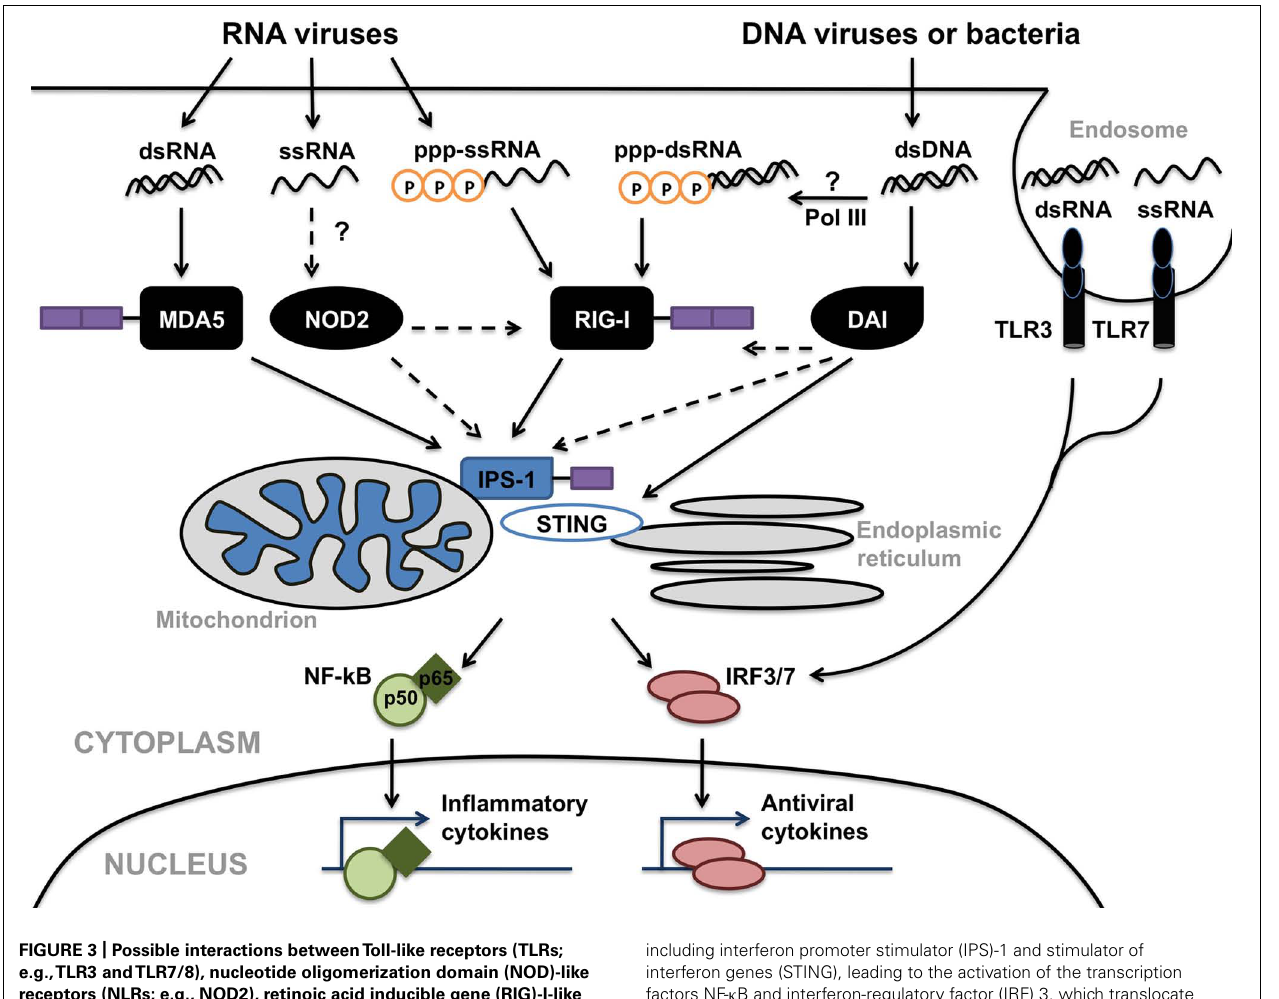
FIGURE 3 | Possible interactions betweenToll-like receptors (TLRs; e.g.,TLR3 andTLR7/8), nucleotide oligomerization domain (NOD)-like receptors (NLRs; e.g., NOD2), retinoic acid inducible gene (RIG)-I-like receptors (RLRs; e.g., RIG-I and MDA5) and DNA-dependent activator of IFN regulatory factors (DAI) in the detection of viruses and the initiation of glial immune responses. These disparate cell surface, endosomal, and cytosolic sensors share common signaling components